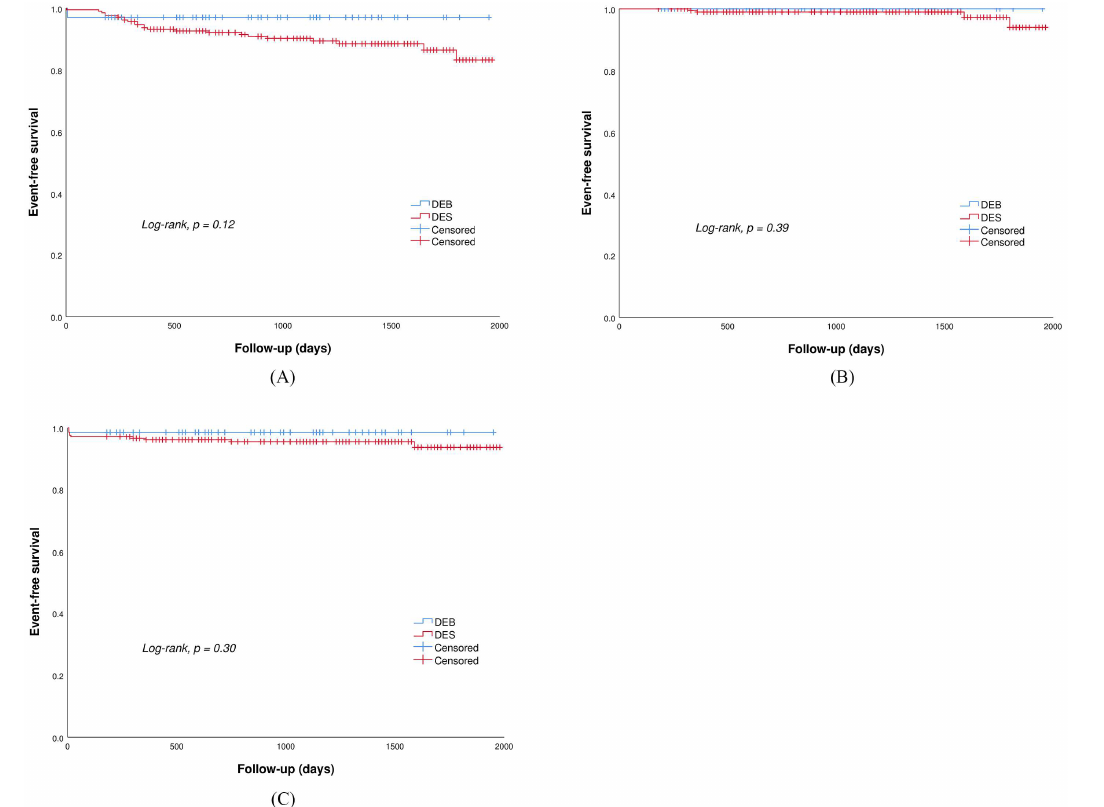
Figure 2. Kaplan–Meier survival curve for ( A ) DOCE: device-oriented composite endpoint; ( B ) heart